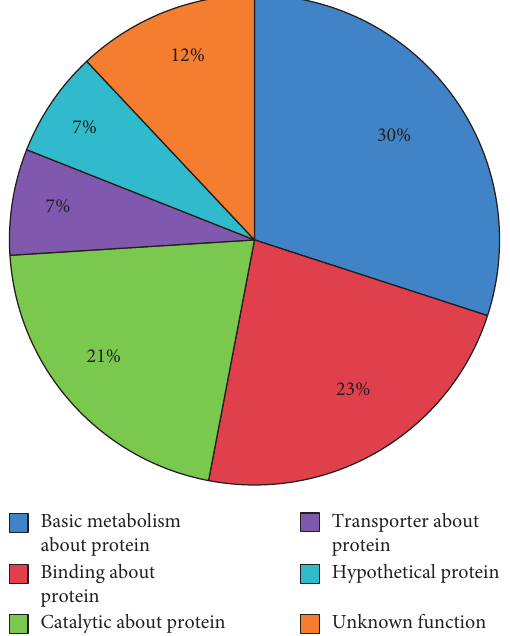
Figure 3: Functional classification of differentially expressed proteins in P. expansum after different